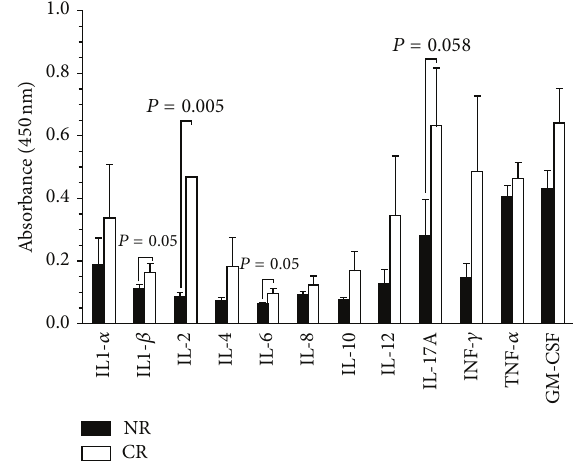
Figure 4: Elevated level of proinflammatory cytokines in plasma of rejected kidney transplant patients. Cytokine and chemokine levels were analyzed using Multi-Analyte ELISArray kits. Cytokine levels fromkidneytransplantpatientswithnoevidenceofrejection (𝑛 = 9) and with chronic rejection (𝑛 = 15) are presented as the mean of absorbance values ± SEM. The 𝑃 value was calculated using Mann- Whitney 𝑈